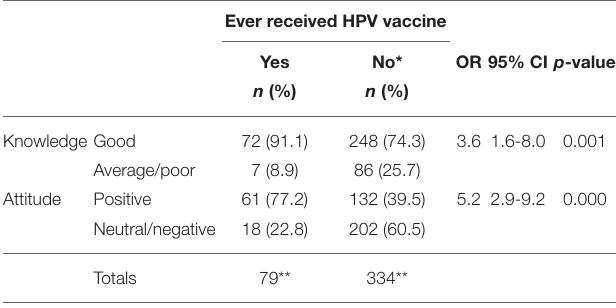
TABLE 8 | Associations between vaccination status and knowledge and attitudes of